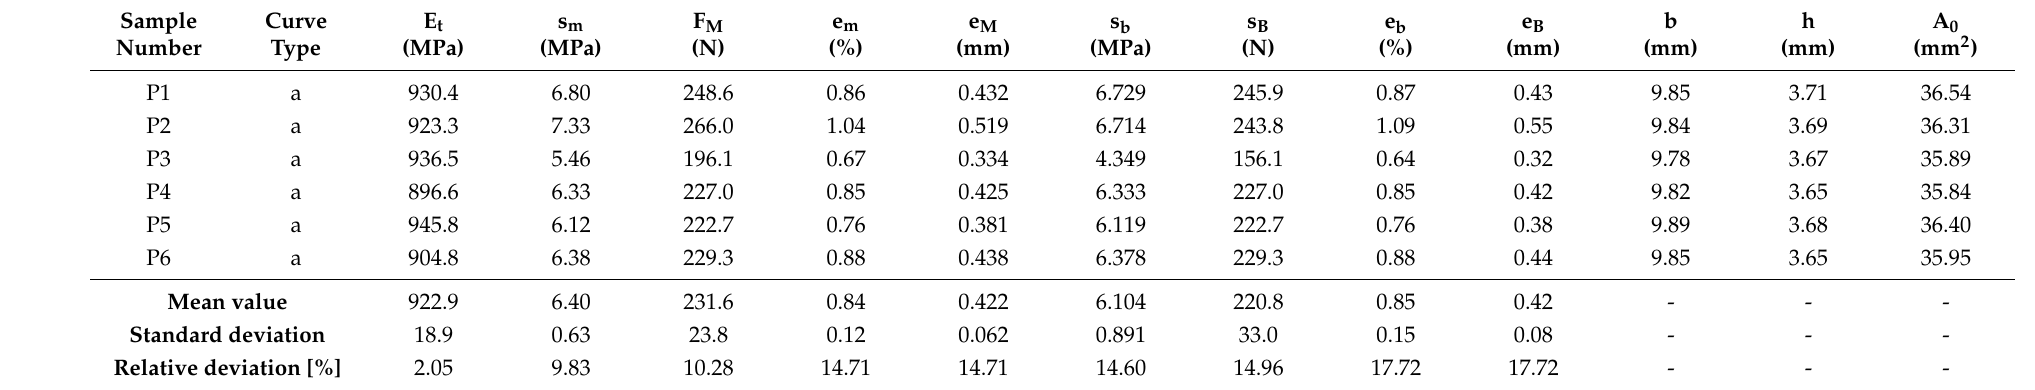
Table A37. Results of the tensile tests of